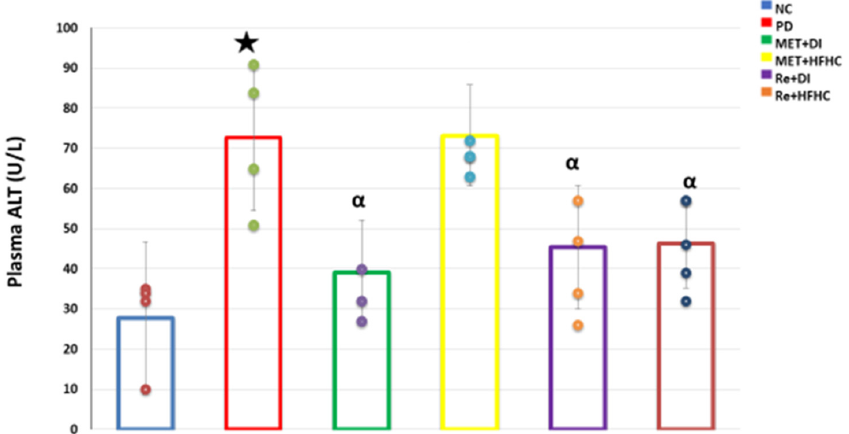
Figure 9. Plasma ALT concentration in normal control (NC), prediabetic control (PD), metformin and diet intervention (MET + DI), metformin and high fat–high carbohydrate (MET + HFHC), rhenium (V) compound and diet intervention (Re + DI) and rhenium (V) compound and high fat–high carbohydrate (Re + HFHC) groups after 12 weeks of treatment. Values are presented as means ± SD and individual data points ( n = 6). (cid:63) p < 0.05 by comparison with NC, α p < 0.05 by comparison with PC, MET + DI, MET + HFHC, Re + DI and Re +